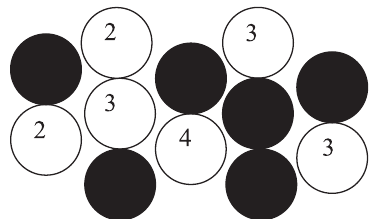
Fig. 4 Schematic representation of the method of calculation of the coordinate mixing